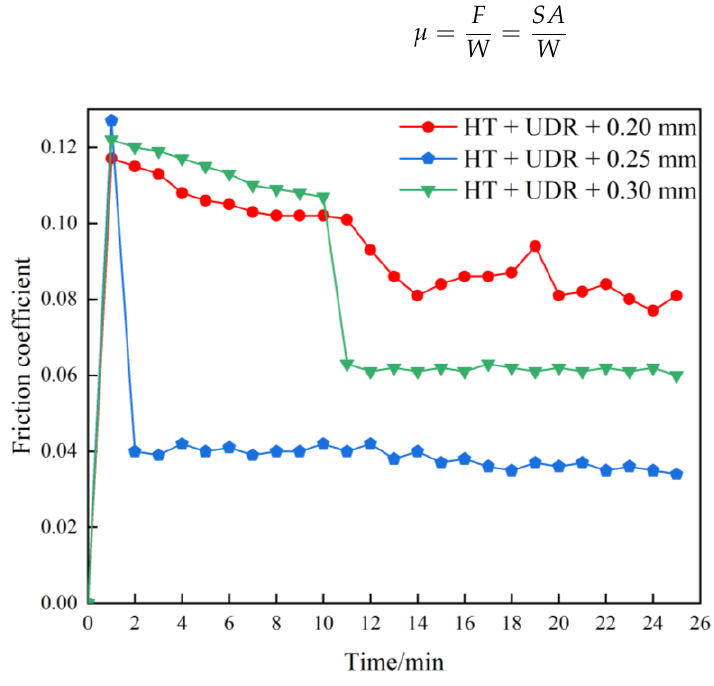
Figure 10. Friction coefficient of the coating under different preloading depths.